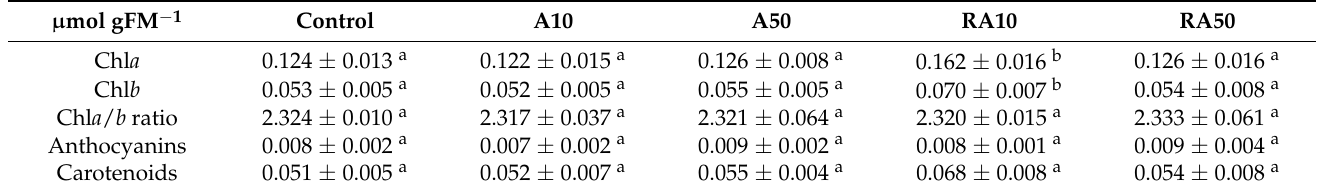
Table 4. Effects of A and RA treatments on chlorophylls, carotenoids, and anthocyanin contents. Different letters mean significantly different values ( p < 0.05).